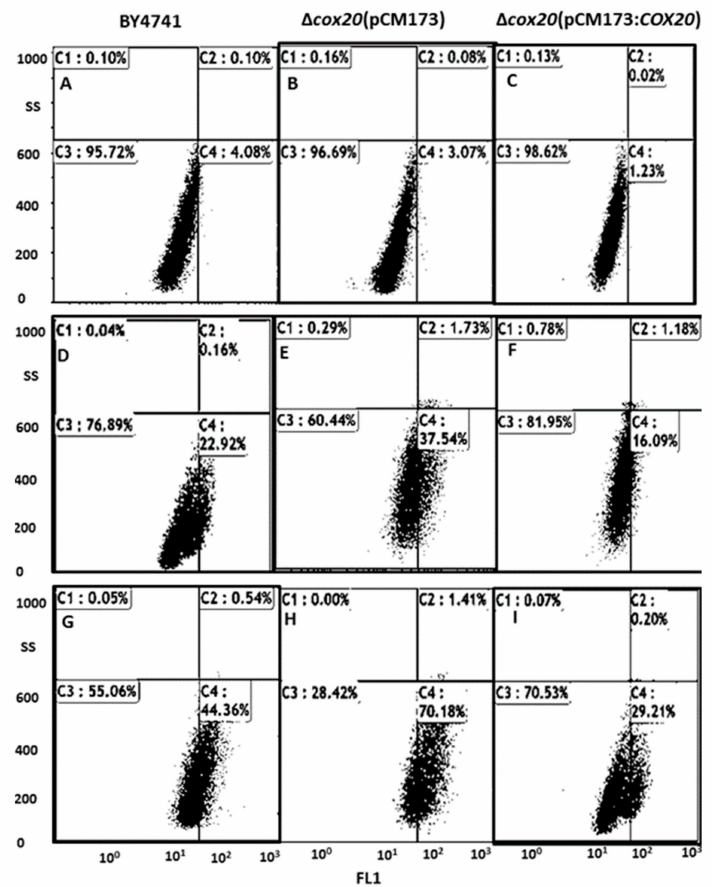
Figure 1. Dot plot diagrams of yeast populations using a flow cytometer with quadrants for ( A ) BY4741- trp1 control, ( B ) ∆ cox20 (pCM173) control, ( C ) ∆ cox20 (pCM173: COX20 ) control, ( D ) BY4741- trp1 , ( E ) ∆ cox20 (pCM173), ( F ) ∆ cox20 (pCM173: COX20 ) in the presence of 0.5 mM pyocyanin, ( G ) BY4741- trp1 , ( H ) ∆ cox20 (pCM173:COX20), ( I ) ∆ cox20 (pCM173: COX20 ) in the presence of 1 mM hydrogen